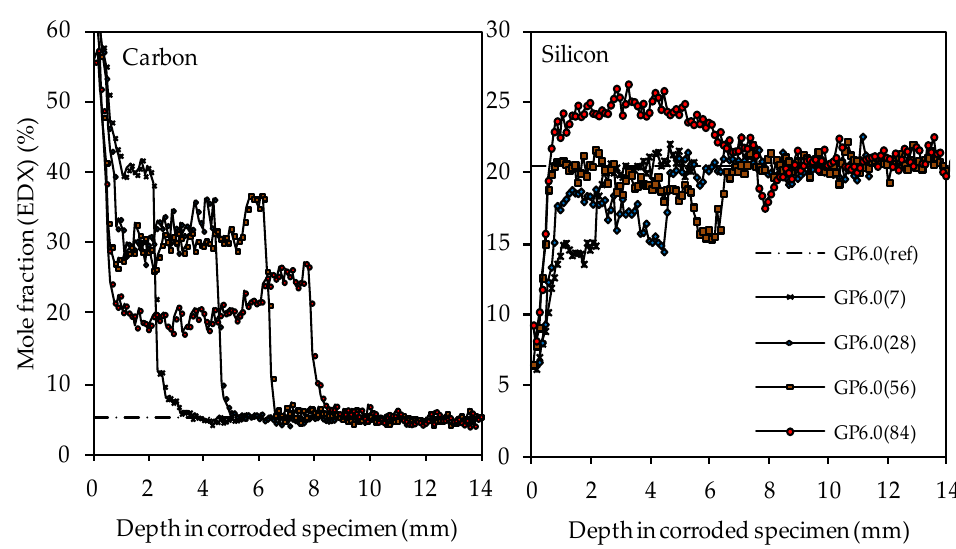
Figure 14. SEM-EDX mole fractions of carbon and silicon of geopolymer GP6.0. Mole fractions before (ref) and after (7, 28, 56, 84) exposure to sulfuric acid.